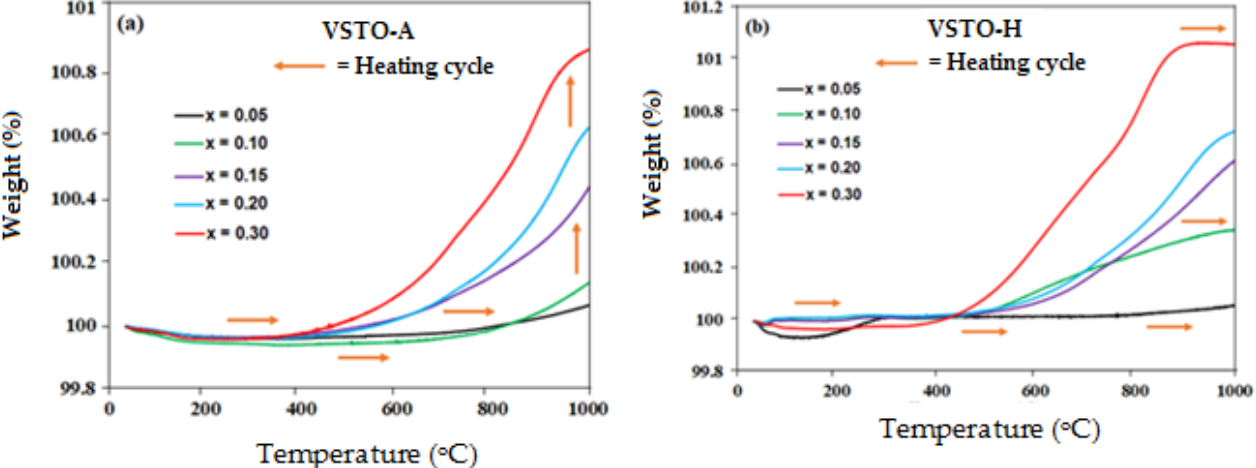
Figure 4. Thermogravimetric analysis showing the oxidation in air up to 1000 °C for ( a ) VSTO-A and ( b ) VSTO-H ceramics.